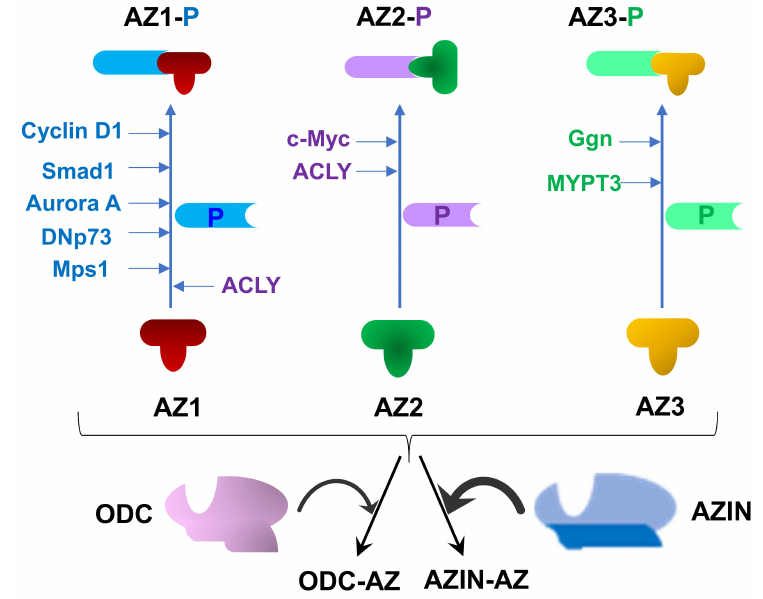
Figure 3. AZ-interacting proteins. The three AZs interact with ODC and AZINs, proteins implicated in polyamine metabolism. In addition, AZs also bind to other proteins not directly related with polyamines. In particular, AZ1 interacts with cell cycle proteins (cyclin D1, Smad, protein kinases such as Aurora A and Msp1), apoptosis related proteins (DNp73, an amino terminally truncated form of p73), or with the acetyl-CoA forming enzyme ATP citrate lyase (ACLY). AZ2 also interacts with ACLY and with the oncogenic protein c-Myc. AZ3 binds to the testicular protein gametogenetin (Ggn), and to MYPT3, a regulatory protein of protein